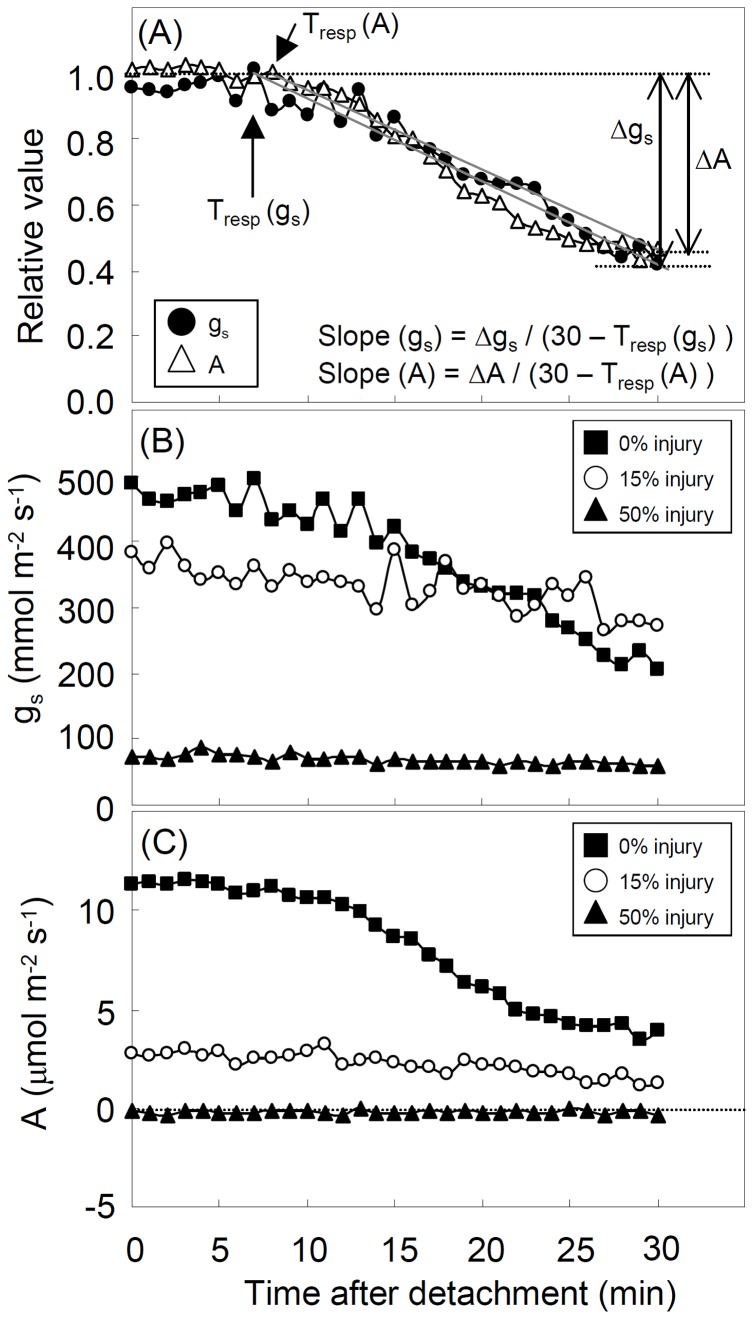
Examples of dynamic response of gs and Amax after detachment of the leaf (A: calculation of the dynamic parameters in a leaf with 0% visible injury, B: time courses of absolute values in gs, C: time courses of absolute values in A).Δgs and ΔA show the range of gs and Amax variation, respectively, over 30 min from the leaf severing. Tresp (gs) and Tresp(A) show the time to start decrease of gs and Amax, respectively. Slope(gs) and Slope(A) show the rate of decrease for gs and Amax, respectively, over 30 min.